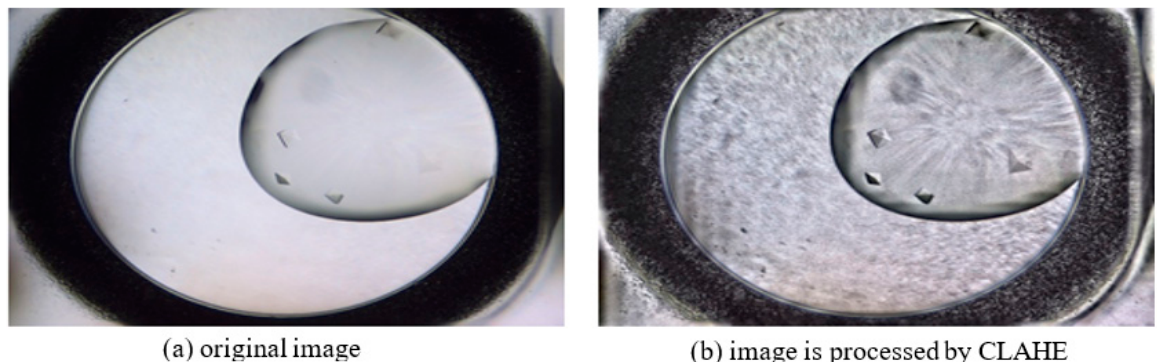
Figure 2. Comparison before and after processed by contrast limit adaptive histogram equalization (CLAHE). ( b ) is the image processed by CLAHE, and it can be clearly seen that the features of the crystal edge in ( b ) are more obvious than in ( a ).